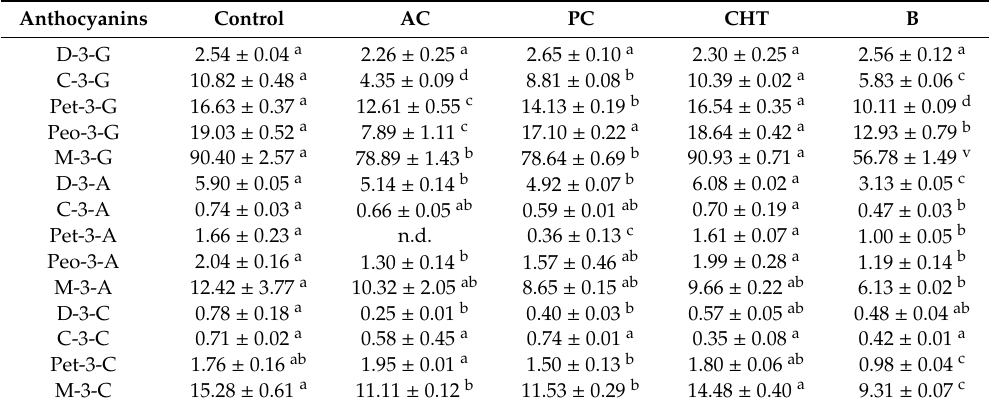
Table 6. E ff ect of fining agents’ application on monomeric anthocyanins (mg / L) in red